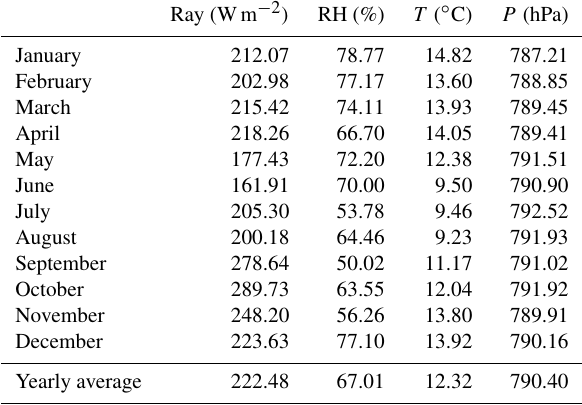
Table A1. Meteorological parameter